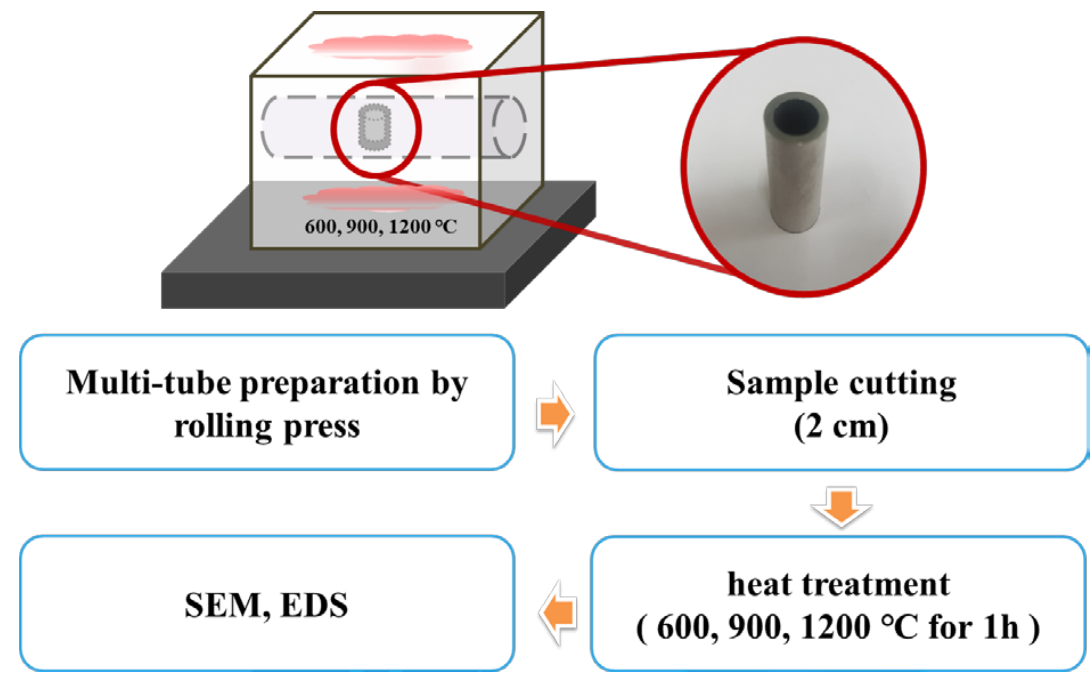
Figure 3. Schematic and conditions of heat treatment.